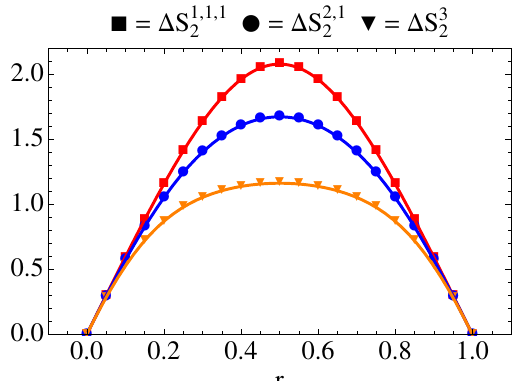
Figure 6 . 2nd R(cid:19)enyi entropies of three particle states for various choices of the momenta: P 1 (cid:25) 10, P 2 (cid:25) 20, P 3 (cid:25) 30 (squares, red curve), P 1 = P 2 (cid:25) 30, P 3 (cid:25) 50 (circles, blue curve) and P 1 = P 2 = P 3 (cid:25) 50 (triangles, light brown curve).